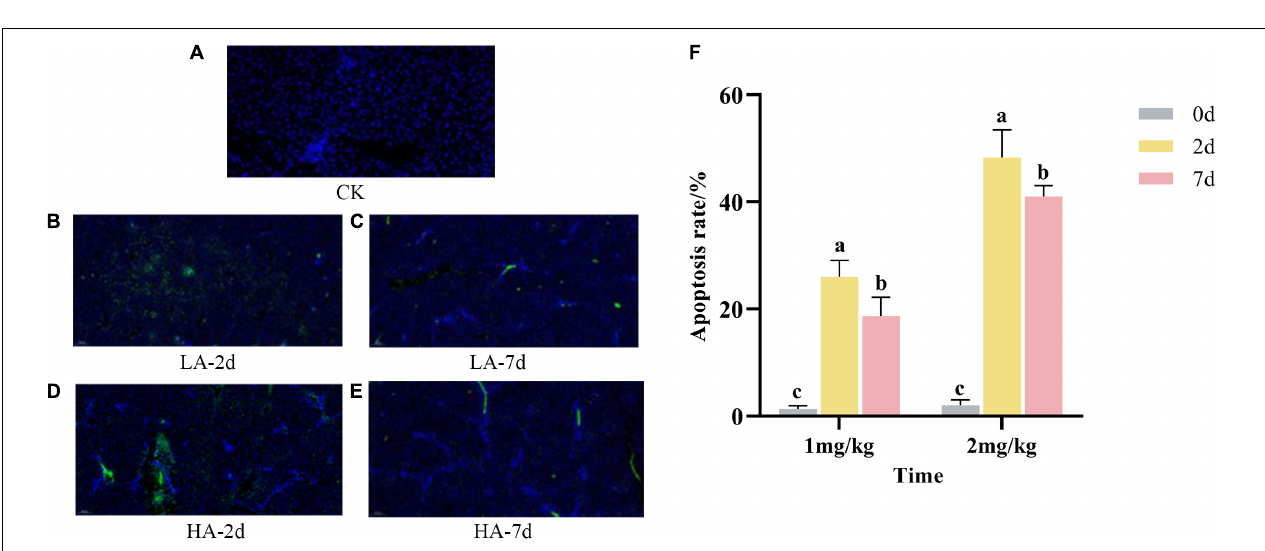
FIGURE 3 | Effect of AFB 1 on apoptosis in rat hepatocytes. (A–E) : representative images of TUNEL staining ( × 200), (F) : TUNEL assay for percentage of hepatocyte apoptosis.